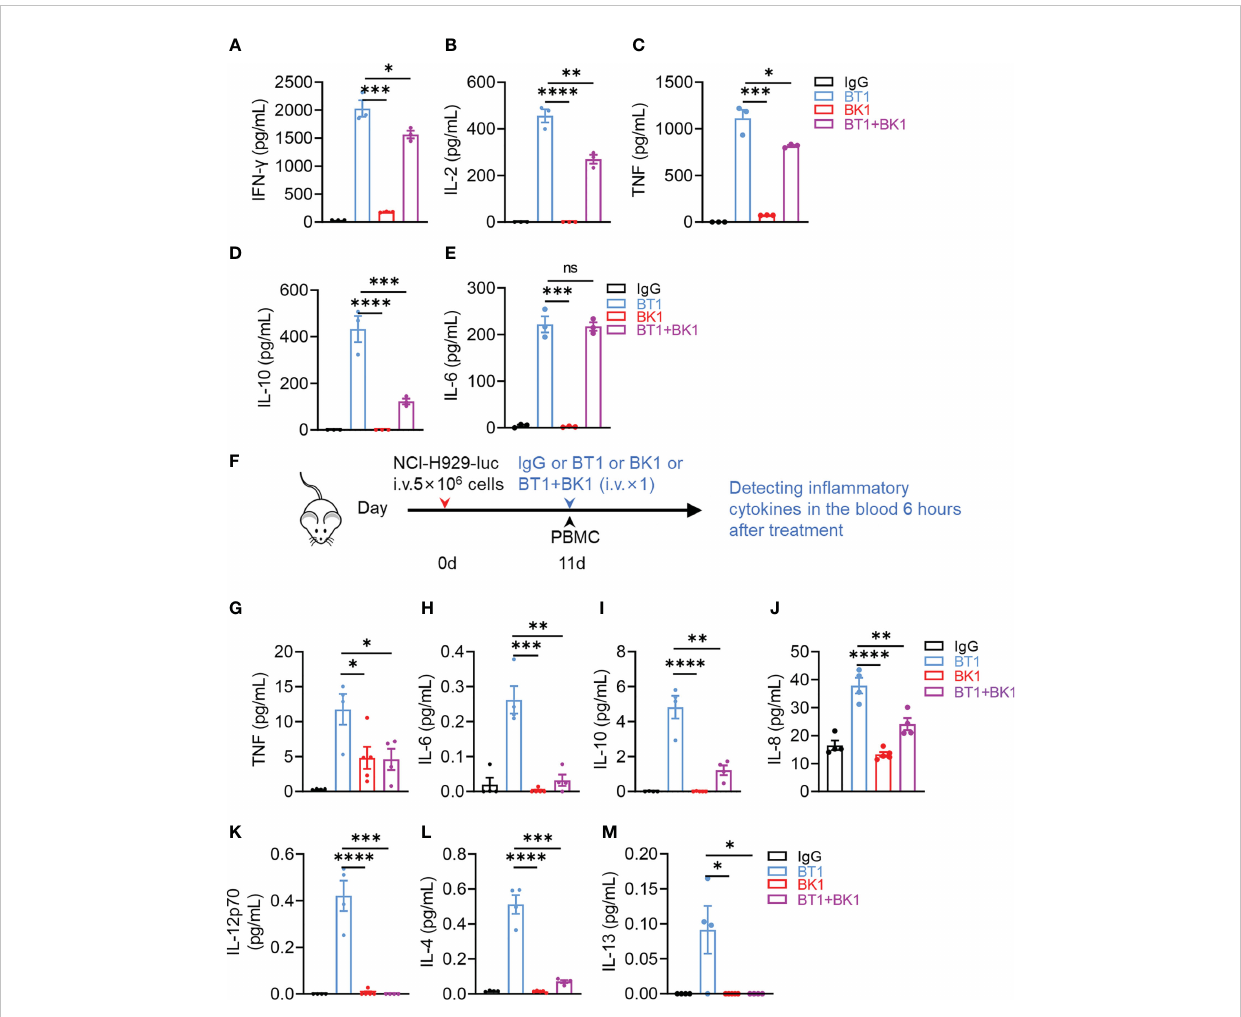
FIGURE 7 BK1 induces less proin fl ammatory cytokine production and reduces cytokine secretion by BT1 in the combined treatment. (A-E) PBMCs were cocultured with MM.1S-luc cells at an E:T-cell ratio of 10:1 in the presence of IgG, BT1, BK1 or BT1 combined with BK1 (1 m g/mL) for 24 h, and the levels of secreted (A) IFN- g , (B) IL-2, (C) TNF, (D) IL-10 and (E) IL-6 in the supernatants were assessed using a CBA Kit. (F) Experimental protocol for the cytokine model used in (G – M) : NSG mice (n = 5/group) were injected intravenously (i.v.) with NCI-H929-luc tumor cells (5 × 10 6 ) on day 0 followed by intravenous injection of PBMCs (2 × 10 7 ) on day 11. Tumor-bearing mice were injected intravenously (i.v.) with IgG, BT1, BK1 or combined treatment (50 m g/mouse) on day 11. In fl ammatory cytokines in the blood were assessed 6 h following treatment. (G-M) Levels of secreted (G) TNF, (H) IL-6, (I) IL-10, (J) IL-8, (K) IL-12p70, (L) IL-4 and (M) IL-13 were assessed using a V-PLEX proin fl ammatory Panel 1 kit. (A-M) : Data are representative of at least three independent experiments. Data were analyzed by Student ’ s t test. ns:P>0.05; *P < 0.05; **P < 0.01; ***P < 0.001; ****P <